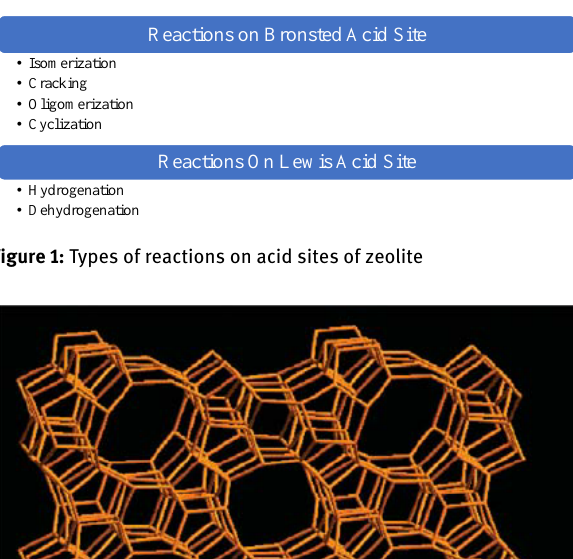
rate-controlling step), is handled on the Lewis acid